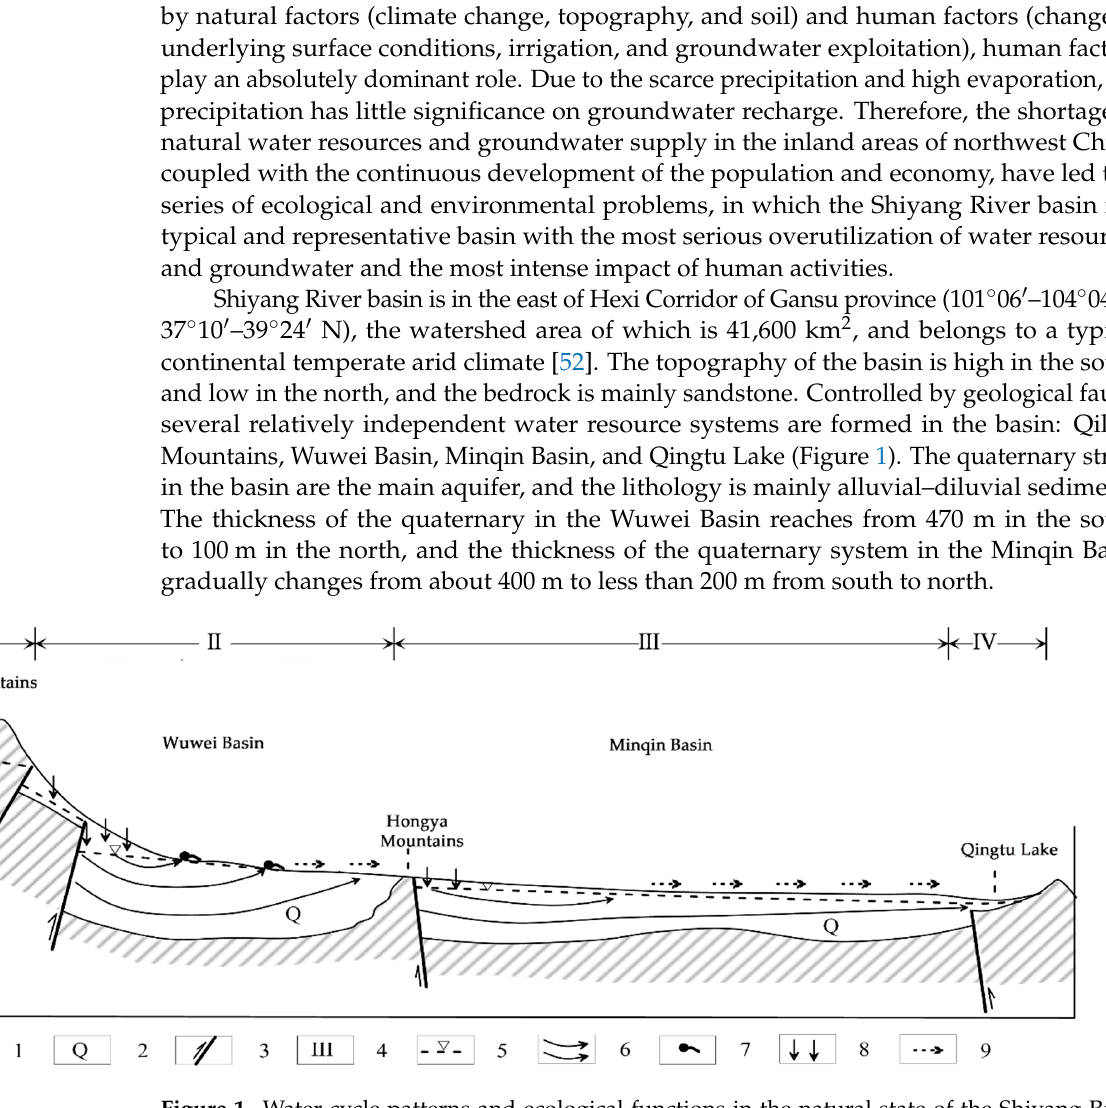
Table 1. Data description of field investigation and collection. Type of Data